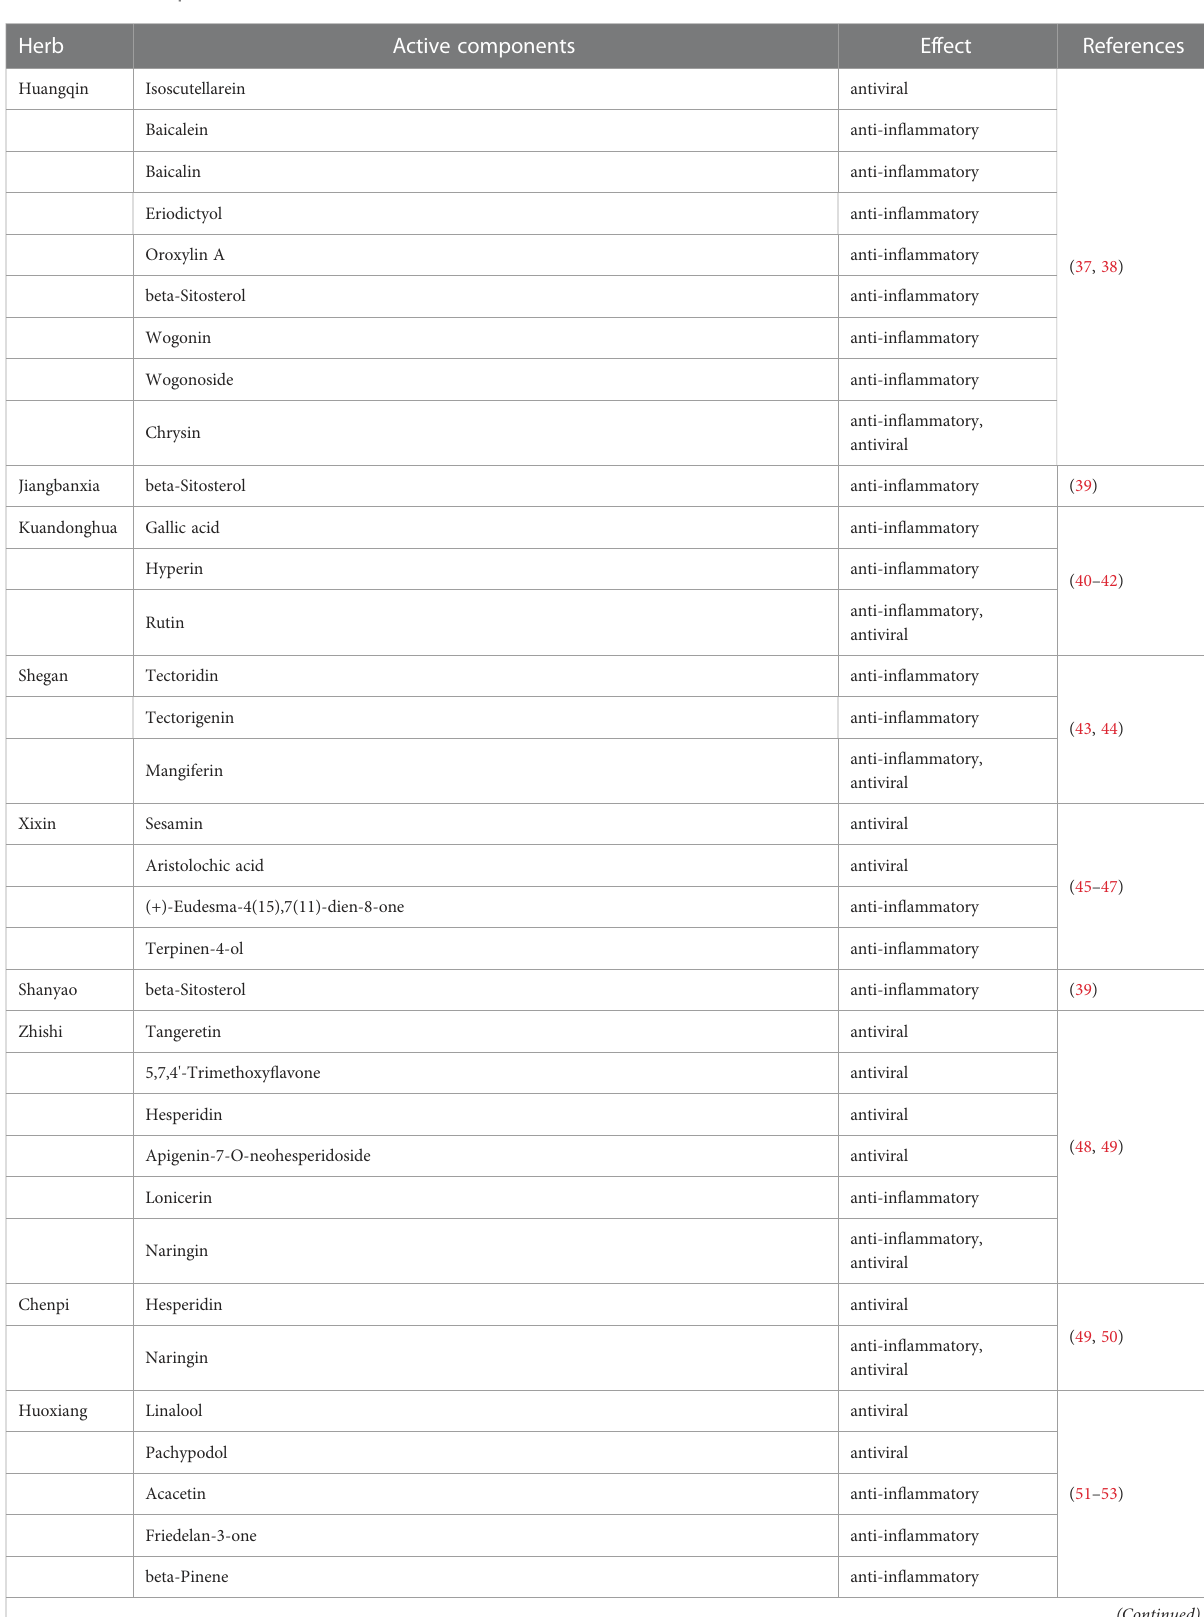
TABLE 1 Active components in QFPD.